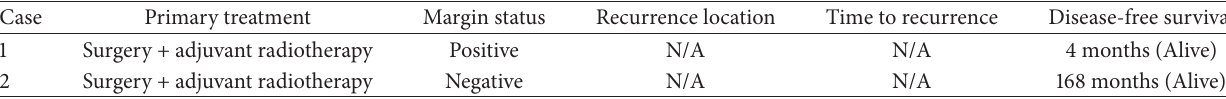
Table 2: Treatment and outcomes of the alveolar soft part sarcoma